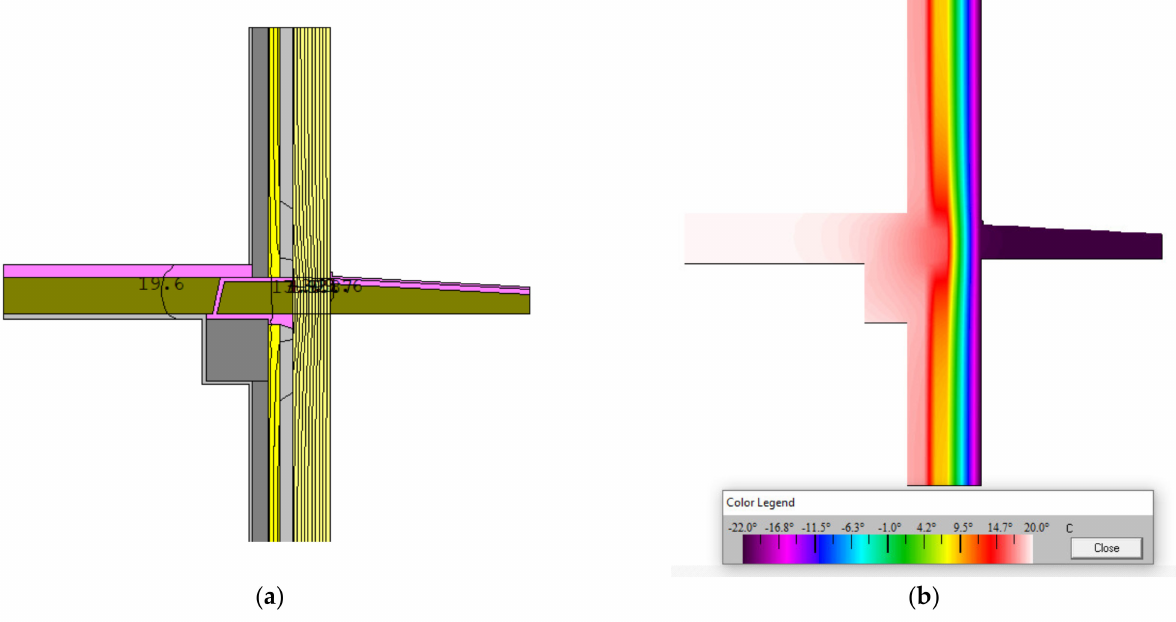
Figure 9. Temperature field in cross-section for scenario IV, wall with 15 cm thick insulation: ( a ) isotherms ( b ) colour scale. Then, the obtained values of the temperature factor for further variants of the calcu- lation were compared with the critical values to assess the risk of surface condensation. The critical temperature factor for five selected cities in each of the five climatic zones of Poland, determined using the Audytor OZC 6.9Pro software (produced by SANKOM in Warsaw, Poland), is presented in Table